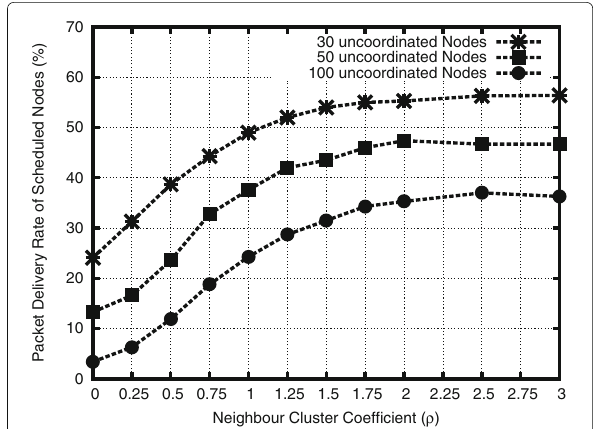
Fig. 5 Packet delivery rate of the scheduled nodes with K = 100,CCA thr = − 85 dBm, and L = 50 sub-slots and different values M